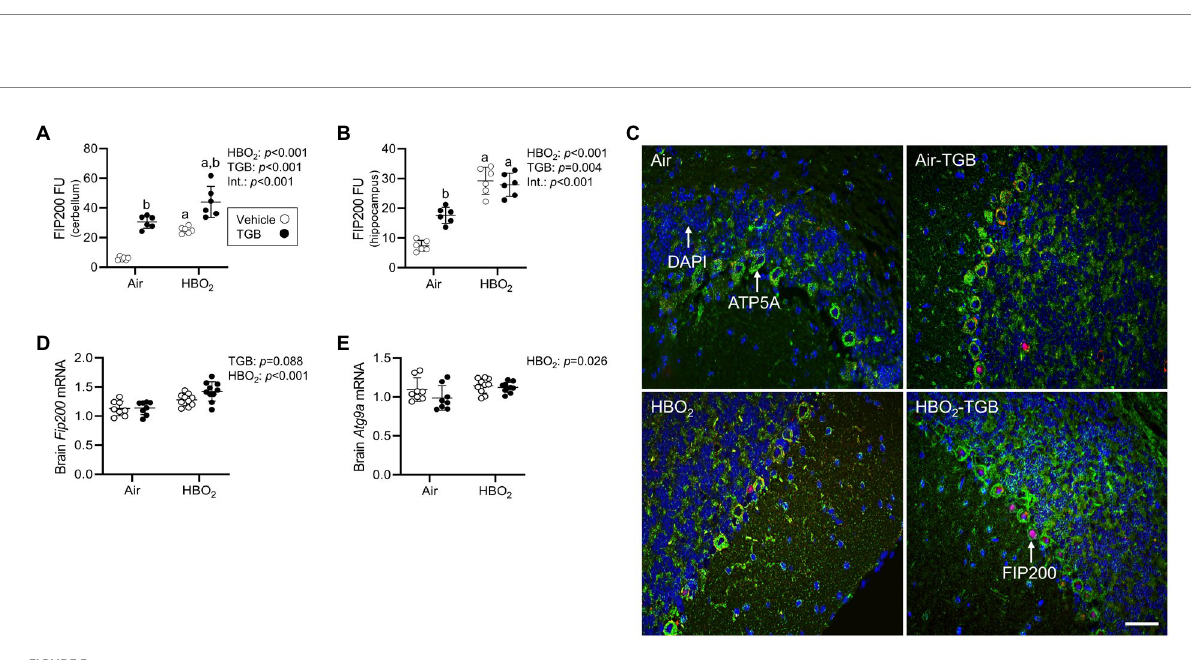
FIGURE 5 Phagophore formation in mice exposed to extreme HBO 2 . Mice were pretreated with 0.9% NaCl or TGB (4.8 mg/kg body weight) 30 min before exposure to air or 5 ATA oxygen for 30 min. (A,B) Quantification of focal adhesion kinase family interacting protein of 200 kD (FIP200) in the cerebellum and hippocampus. (C) Representative images from cerebellum. FIP200 (red), ATP synthase F1 subunit α (green) and DAPI (blue). Scale bar = 20 μ m. (D,E) Fip200 and autophagy-related protein 9A ( Atg9a ) mRNA expression in brain homogenates ( n = 8–10/group). Main effect of a HBO 2 and b TGB, p <